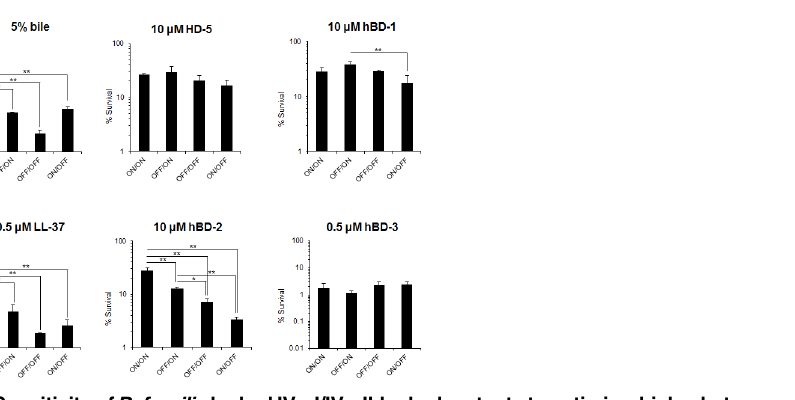
Fig 8. Sensitivity of B . fragilis locked IVp-I/IVp-II-locked mutants to antimicrobial substances. Mid-log growth-phase mutant cells (ON/ON, OFF/ON, OFF/OFF, or ON/OFF) were suspended in PBS (10 7 cfu/ml) and mixed with bile, LL-37 or defensins (human α -defensin 5 [HD-5], or human β -defensins-1 [HBD-1], -2 [HBD-2], or-3 [HBD-3]) at the indicated concentrations. After the mixtures were incubated at 37°C for 30 min (for bile) or 1 h (for LL-37 and defensins), the surviving cells were enumerated. The columns show the ratios of surviving cells to initial viable cell numbers. The data are expressed as the mean ± standard deviation. The differences were statistically analyzed by ANOVA, followed by Tukey ’ s test. P -values of less than 0.05 and 0.01 are indicated as * and ** ,